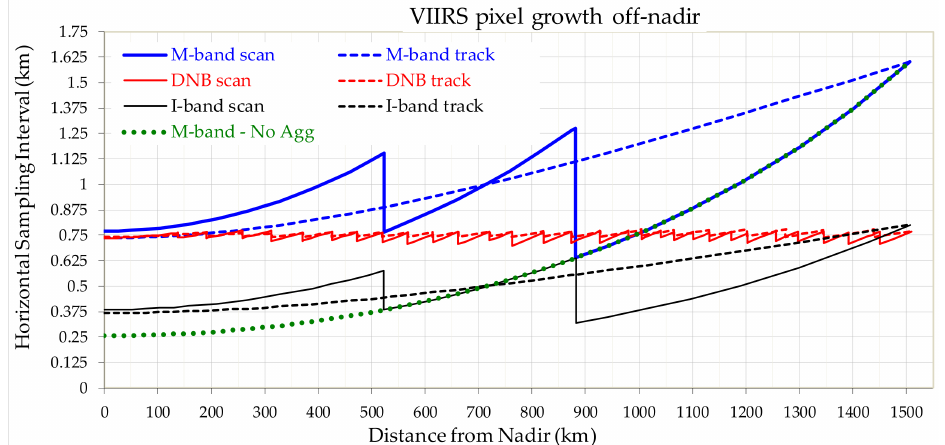
Figure 1. Dependence of pixel size on the off-nadir distance on the ellipsoidal Earth surface for a nominal build of VIIRS sensor. The curve for the “M-band—No Agg” in the plot is for dual gain M-bands in the scan direction before they are aggregated on the ground. Pixel growth in the track direction is unaffected by aggregation scheme for I-bands and M-bands. The pixel sizes are calculated using nominal instrument design values and satellite altitude of 828 km near the Equator (for improvement over MODIS pixel growth, see Figure 4 in